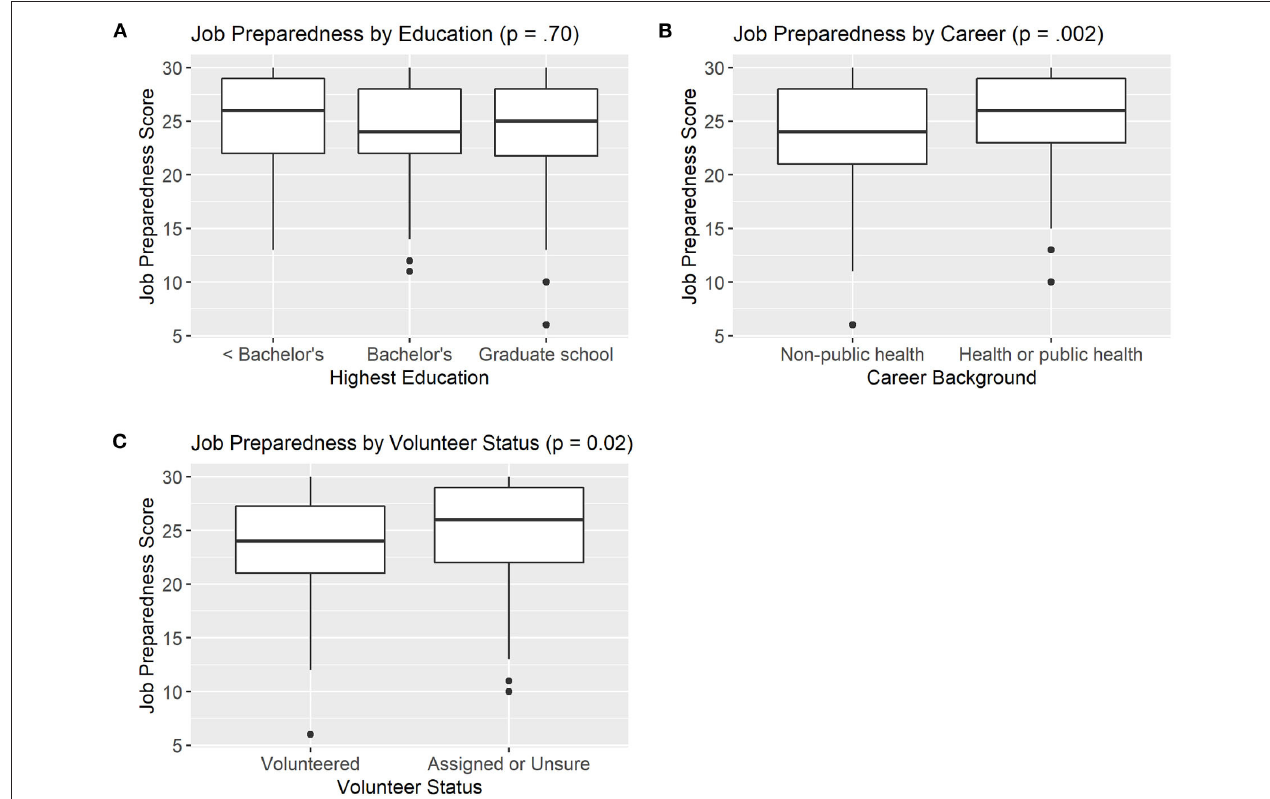
FIGURE 2 | Differences in Self-Perceived Job Preparedness by Education Level ( A , n = 386), Career Background ( B , n = 356), and Volunteer Status ( C , n =